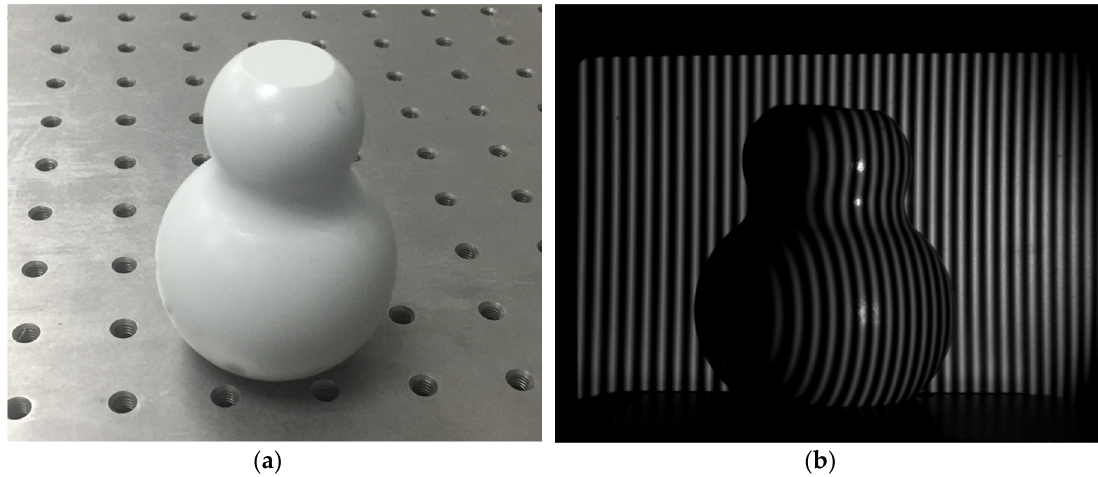
Figure 11. ( a ) Measured calabash; ( b ) measured calabash’s structured light fringe pattern.